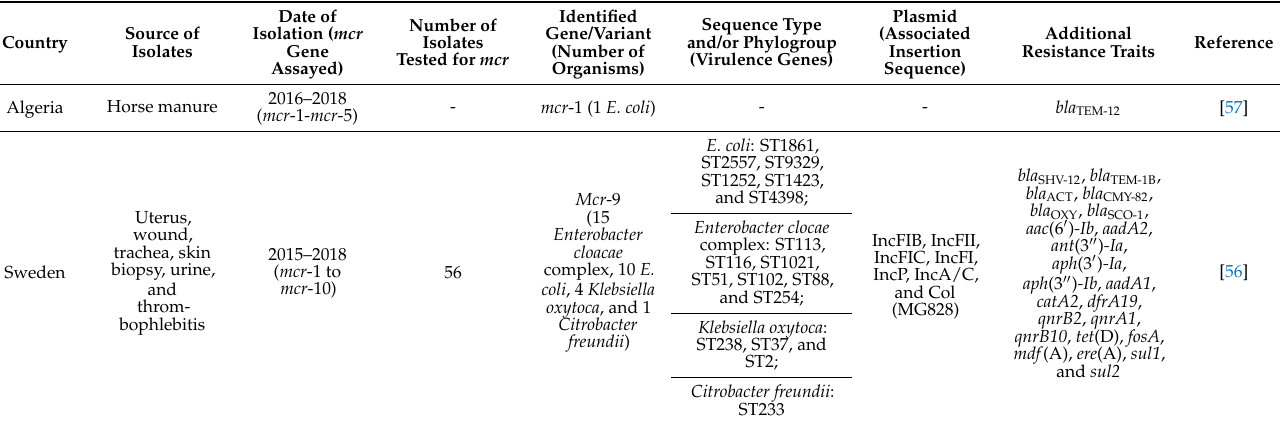
Table 1. Studies reporting on plasmid-mediated colistin resistance in